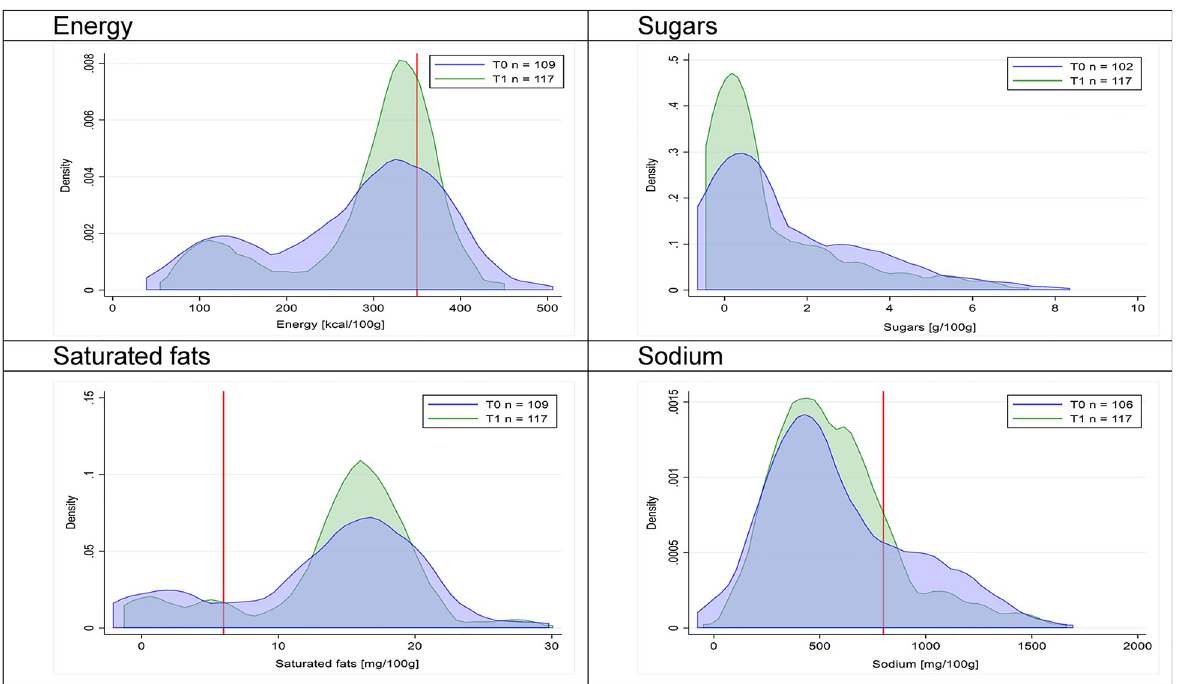
Fig 13. Density curves for the amount of energy and nutrients of concern in cheeses, cross-sectional samples. The blue line represents the distribution in T0 (preimplementation), the green line represents the distribution in T1 (postimplementation), and the red line represents the cutoff for the amount of energy or nutrients of concern.